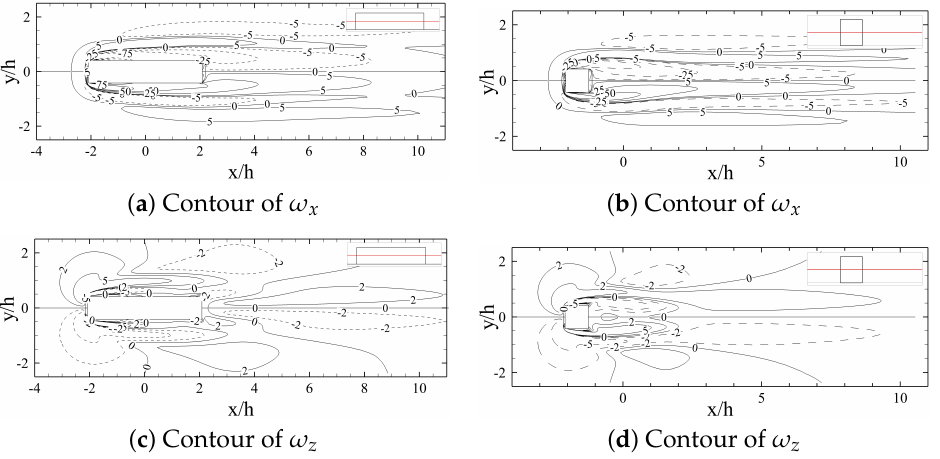
Figure 19. The contours of vorticity at the mid-height plane of the ( a , b ) long-rectangular prism and ( c , d ) square prism. The dotted lines indicate negative